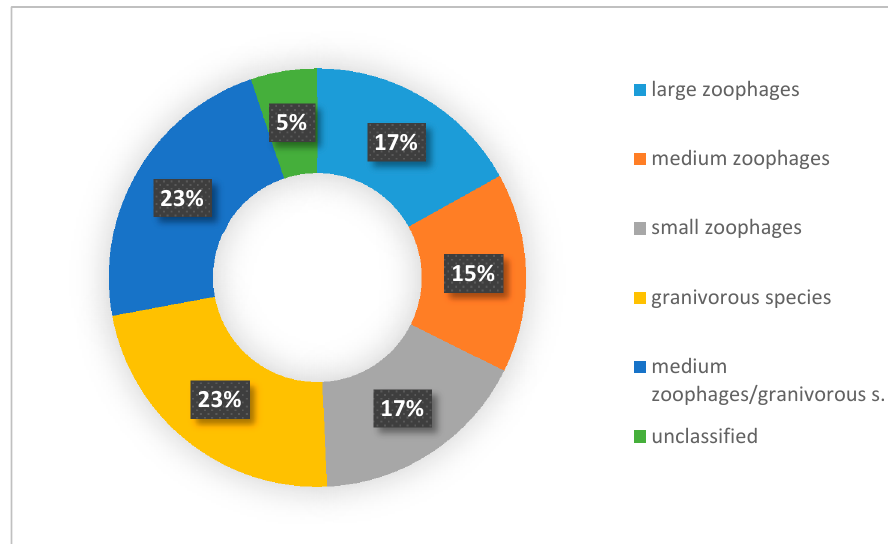
Figure 9. Percentage of Carabidae species from different trophy groups. This diagram was made based on selected publications, including data on the ecological characteristics of Carabidae communities inhabiting the investigated plants.